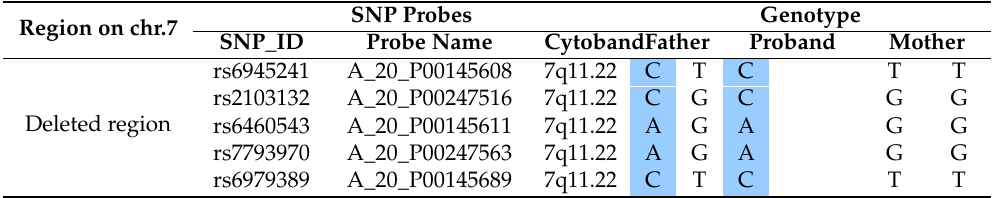
Table 1. Segregation pattern of informative Single Nucleotide Polymorphisms (SNPs) from the parents to the proband mapped within the proband’s deleted (7q) region. In this region, only SNPs from the father (highlighted by a light blue background) are present.